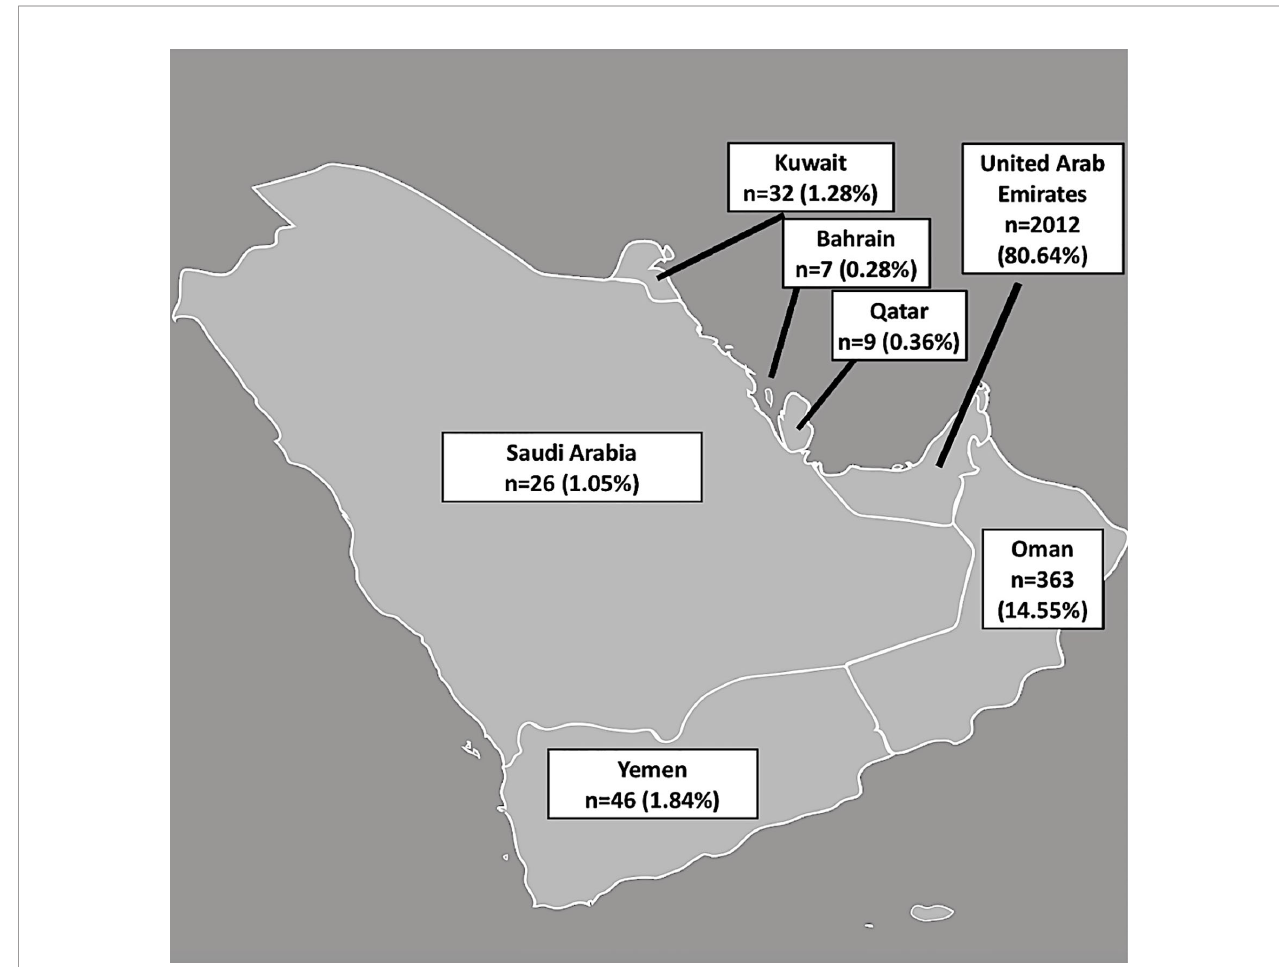
FIGURE 1 | Number and percentage of women included from each country from the Arabian